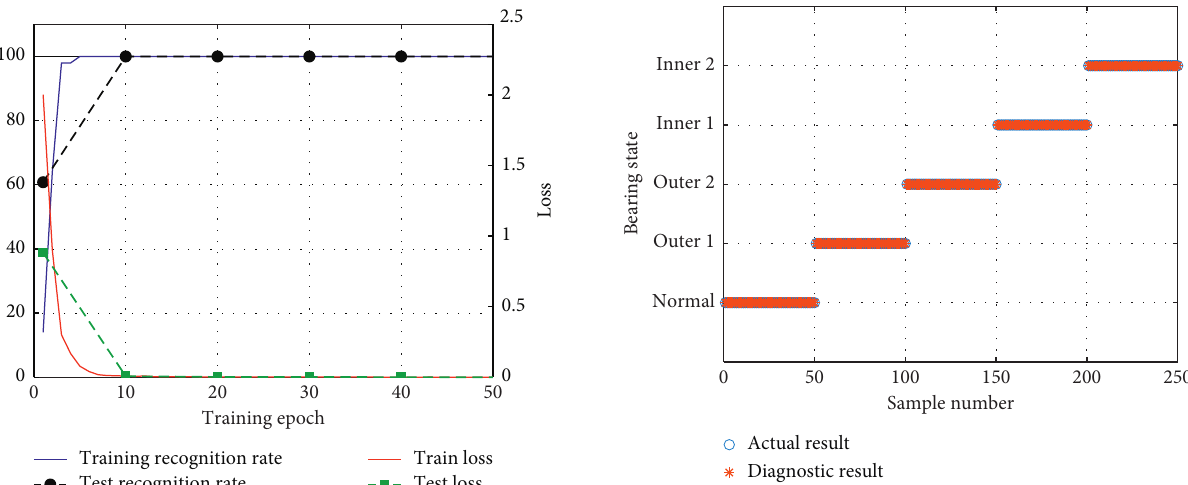
Figure 25: Degradation identification